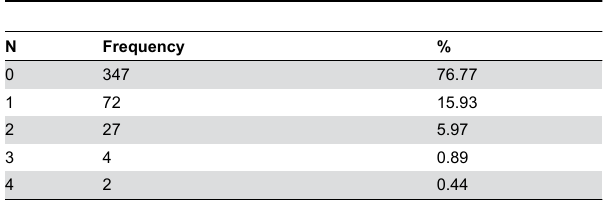
Table 3. Number of stacks per 60 nm cell section (N) observed in 452 cells from Epon ultrathin sections of P. deceptionensis M1 T processed by